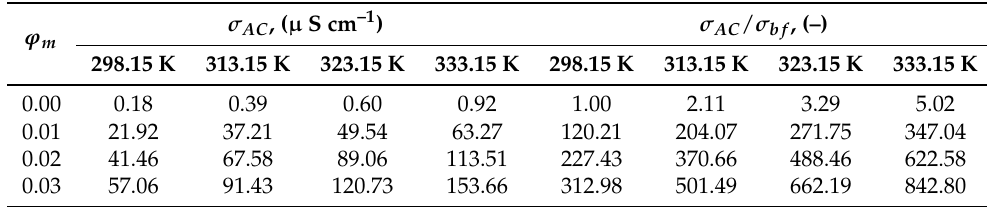
Figure 12. Values of DC electrical conductivity vs. temperature for silicon oxide lignin nanofluids with various mass fractions ( a ) calculated based on Nyquist plots (Figure 9 and Equation (2)), and ( b ) their enhancement, ( c ) calculated based on AC conductivity (Figure 13) and ( d ) their enhancement, ( e ) directly measured by DC conductivity probe and ( f ) their enhancement, ( g ) comparison of results obtained with different methods and ( h ) their enhancement. Table 3. Values of DC electrical conductivity, σ AC , of silicon oxide lignin ethylene glycol nanofluids and their enhancement for various temperatures and mass fractions calculated based on AC conductivity plots (Figure